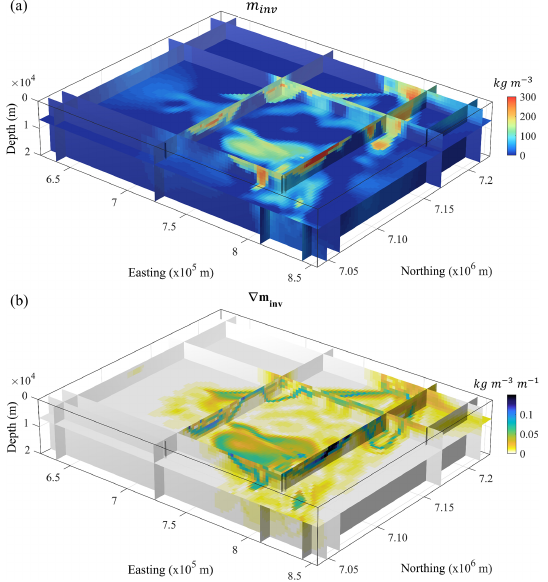
Figure 6. Inverted model obtained from geophysical inversion of field geophysical data (a) and corresponding spatial gradient of den- sity contrast (b) .